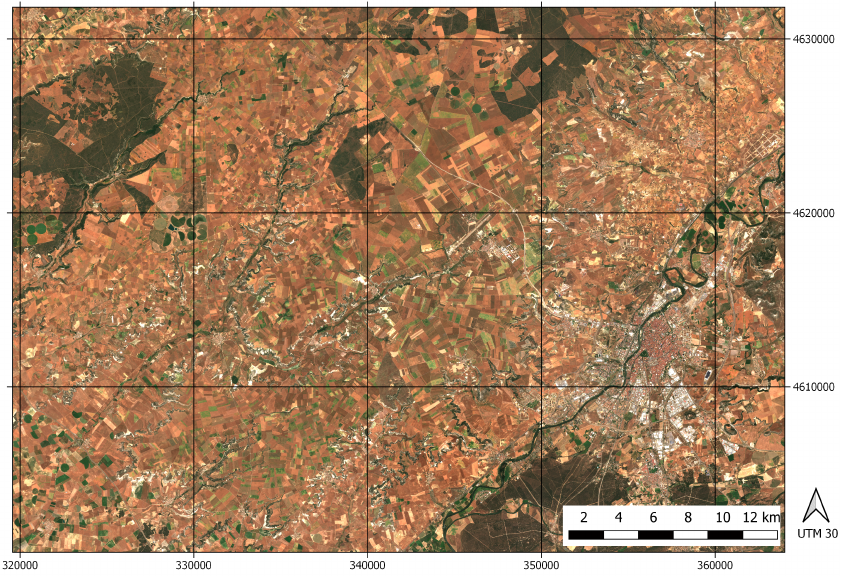
Figure 1. RGB image of the crop ROIs in Castile and Leon region, Northwest Iberian peninsula, from Sentinel 2 capture of 26 June